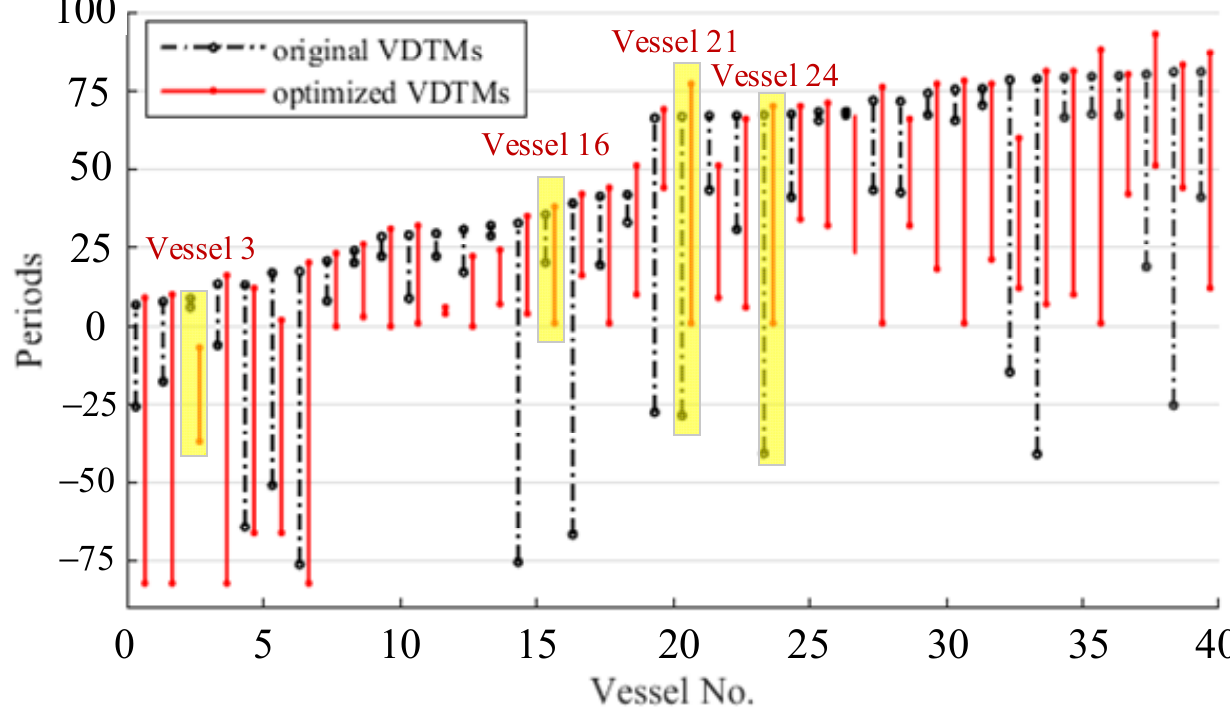
Figure 9. The comparison between original VDTMs and optimized VDTMs. Figure 11 compares the original truck arrivals and optimized truck arrivals. It can be seen that through the optimization of VDTWs, the truck arrivals in each period are flattened, so that the average trucks waiting time at terminal gate in peak hours is significantly reduced, as is shown in Figure 12. The average waiting time of trucks at gate is reduced from 1.225 min to 1.131 min, and the longest waiting time decreases from 2.339 min to 1.985 min. Trucks’ waiting times at the terminal gate and container yard are estimated by the cumulative flow counts-based method according to